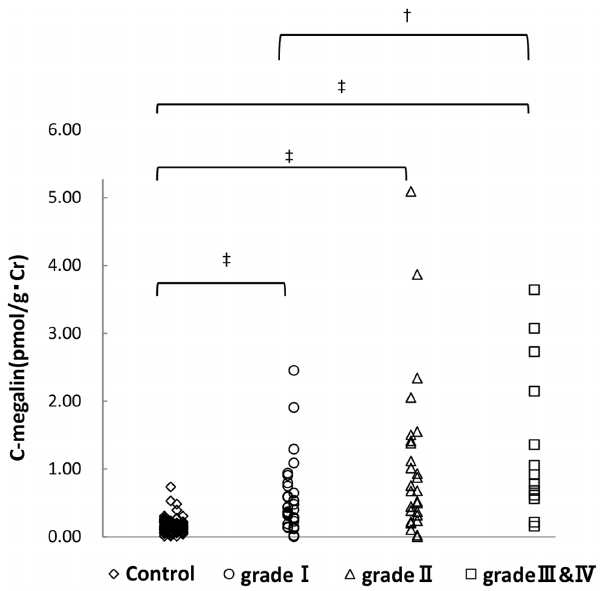
Fig. 1. Relationship of risk levels of requiring dialysis to levels of urinary C-megalin. The numbers on horizontal bars means; control, control subjects (N 5 77); I, low risk group (N 5 33); II, medium risk group (N 5 27); III and IV, high and super high risk group (N 5 13). { , p , 0.05; { , p , 0.001.